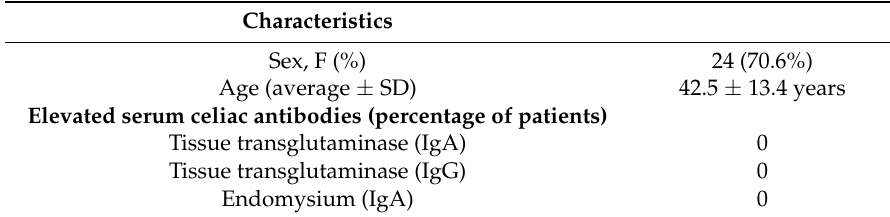
Table 1. Patients’ demographic and clinical characteristics at